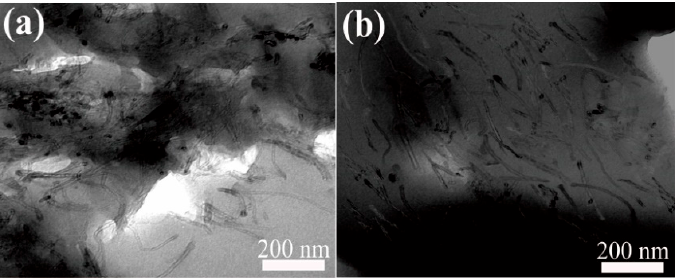
Figure 12. Cross-sectional TEM of PVDF composite membranes with 5 wt% oriented ( a ) VS. non- oriented mCNTs grafting diblock chains ( b ).